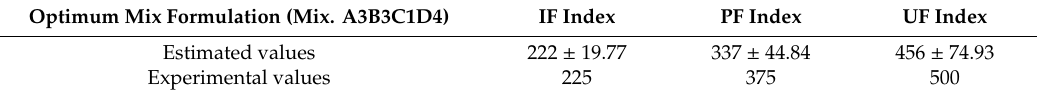
Table 9. Confirmation test for the optimum level condition.